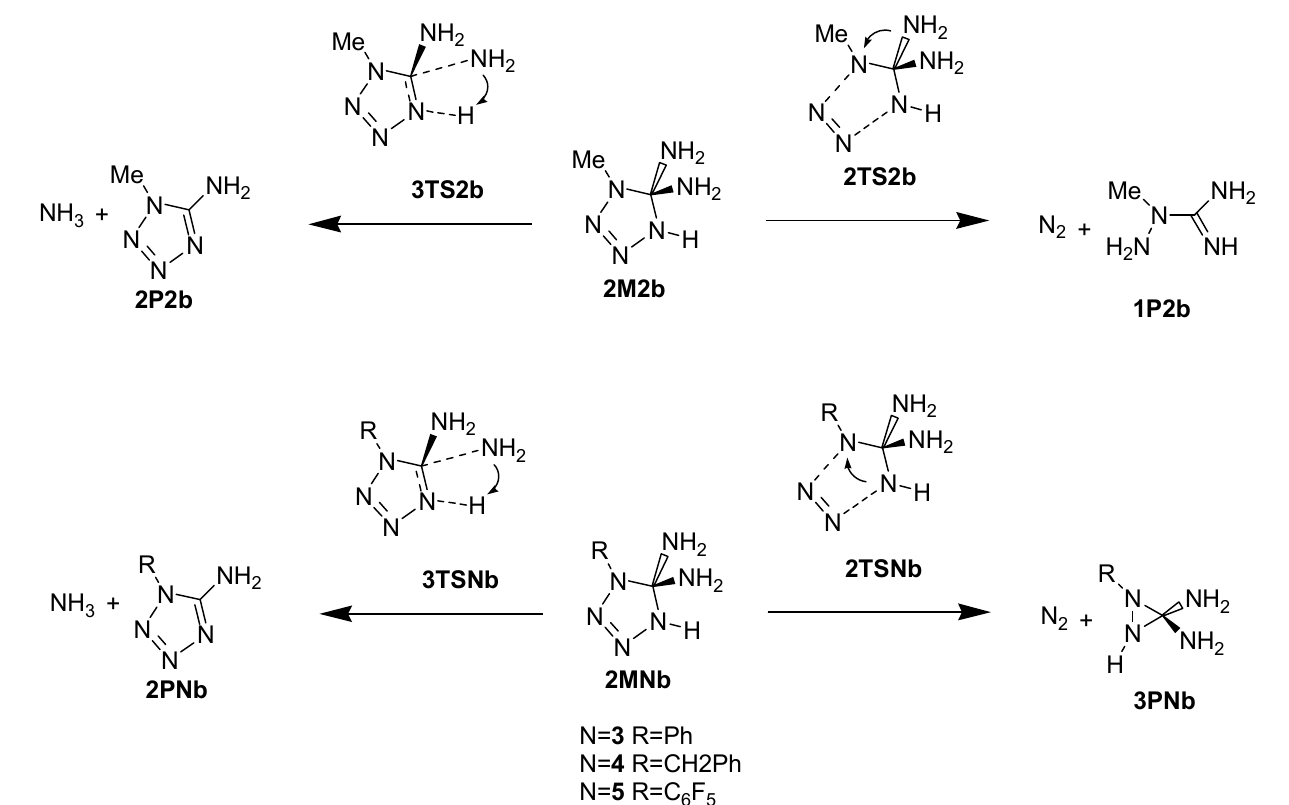
Figure 10. Schematic representation of the rearrangement of adducts from the addition of azide to guanidine in the direction (b).